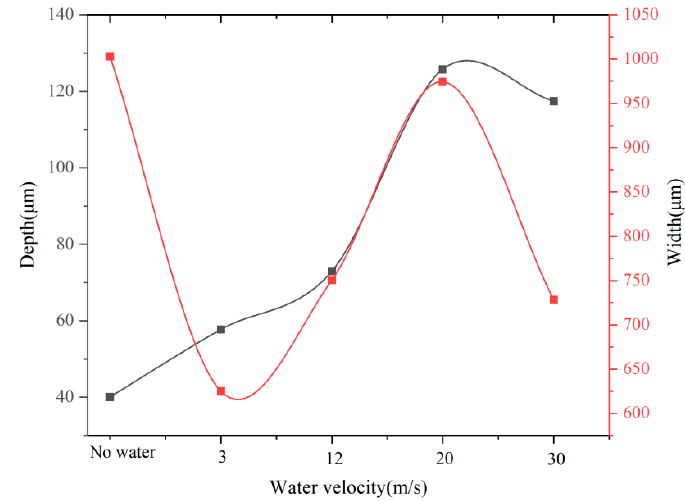
Figure 4. Variation trend of depth and width.